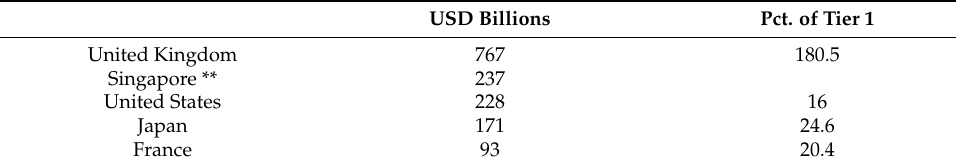
Table 2. Banks’ exposures to China and Hong Kong *.